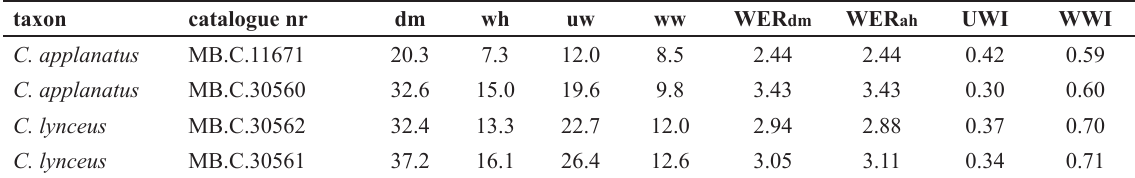
Table 14. Conch measurements (in mm), ratios and rates of coiled conchs of Cyclolituites Remelé,